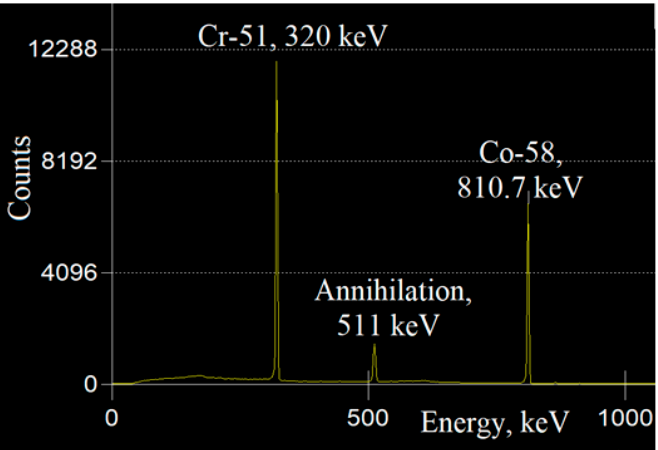
Figure 7. The measured gamma-spectrum of the NAA satellite after